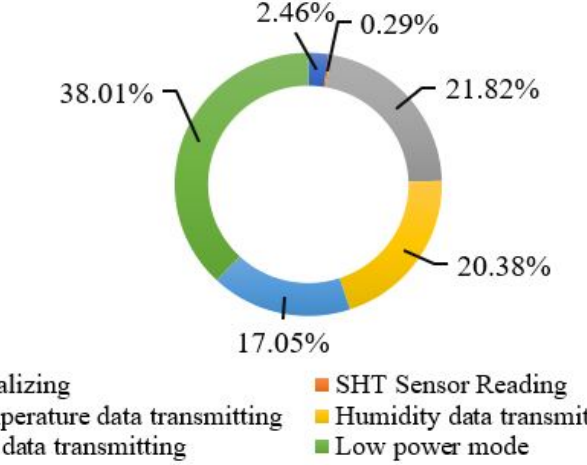
Figure 16. Energy capacity requirement percentage.